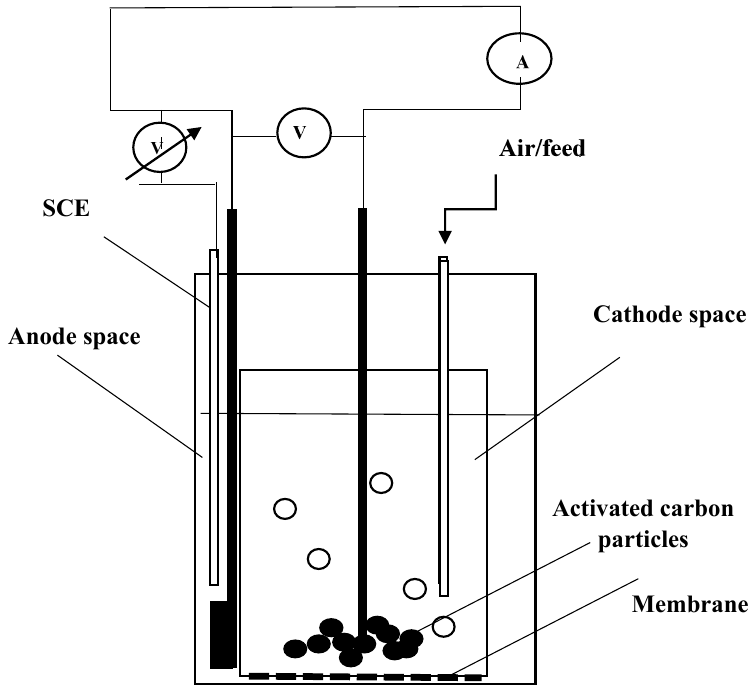
Figure 10. A sketch of the cylindrical fuel cell used for voltammetric